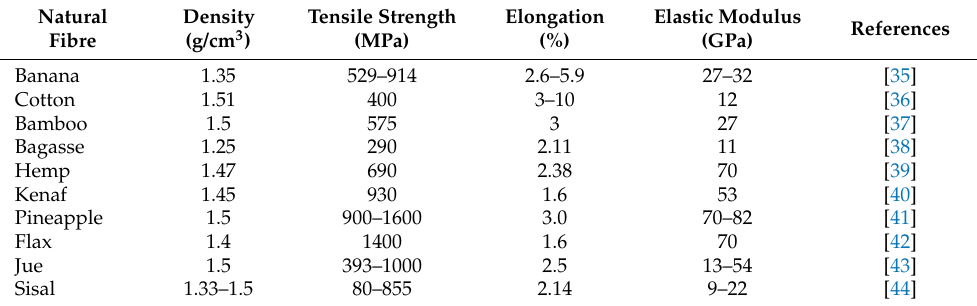
Table 3. Summary of natural fibre properties from researchers.